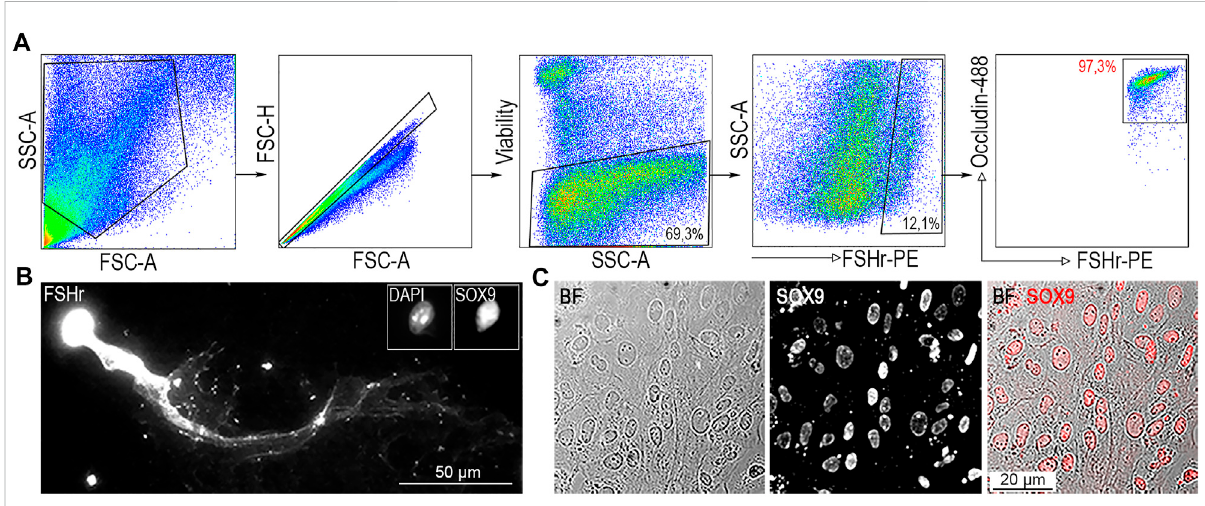
FIGURE 2 Identi fi cation of SCs from ST single cell suspension. (A) A single cell suspension generated from ST was incubated with FSHr-PE and Occludin- 488 antibody. All FSHr + cells positive for Occludin were sorted (right panel, red gate). Sorting gate contains 97,3% of cells. (B) To con fi rm speci fi city, double positive cells were analyzed by immuno fl uorescence microscopy to determine the presence of the transcription factor (TF), SOX9. (C) Immuno fl uorescence analysis of FSHr + Occludin + double positive cell population cultured on a Petri dish con fi rming homogenity in the expression of SOX9